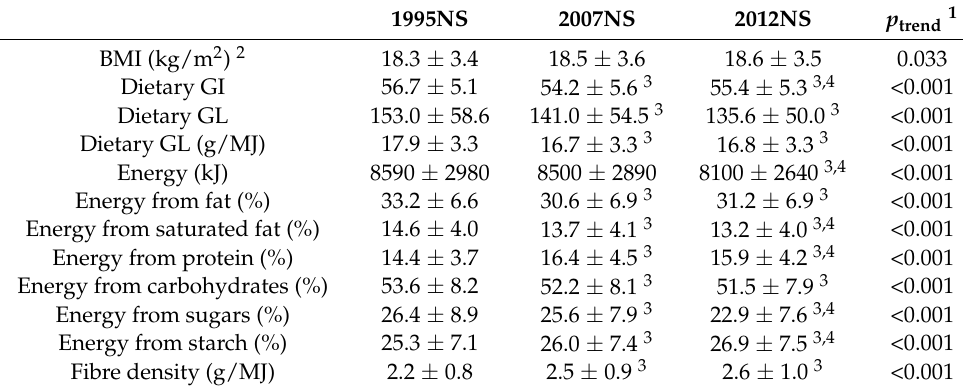
Table 2. Mean ± SD daily glycemic index, glycemic load and intake of macronutrients of respondents of the three